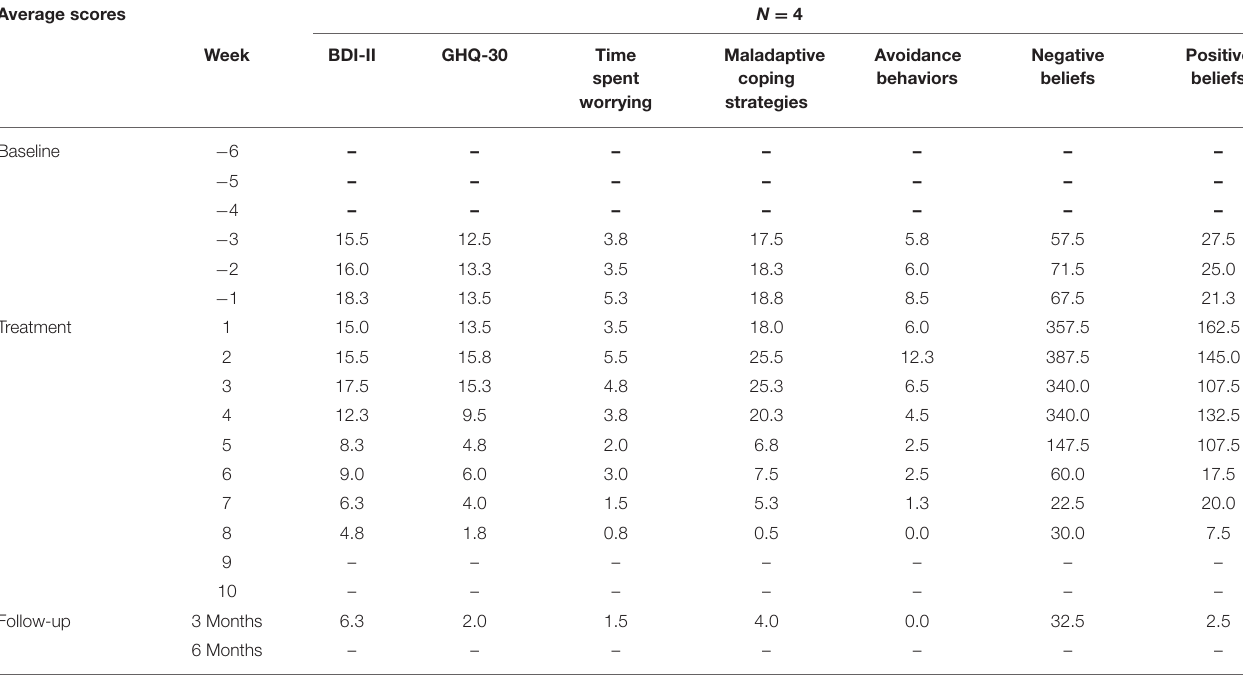
Average scores are computed for complete data only.